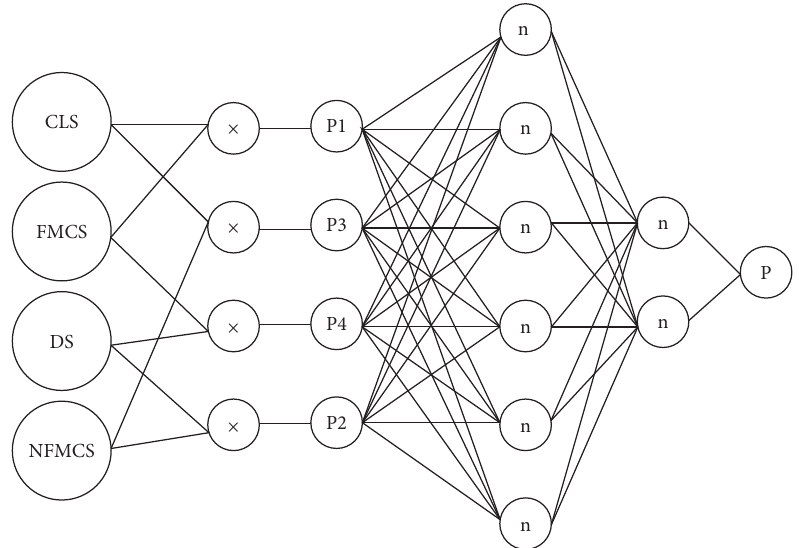
Figure 4: The architecture of deep interaction neural